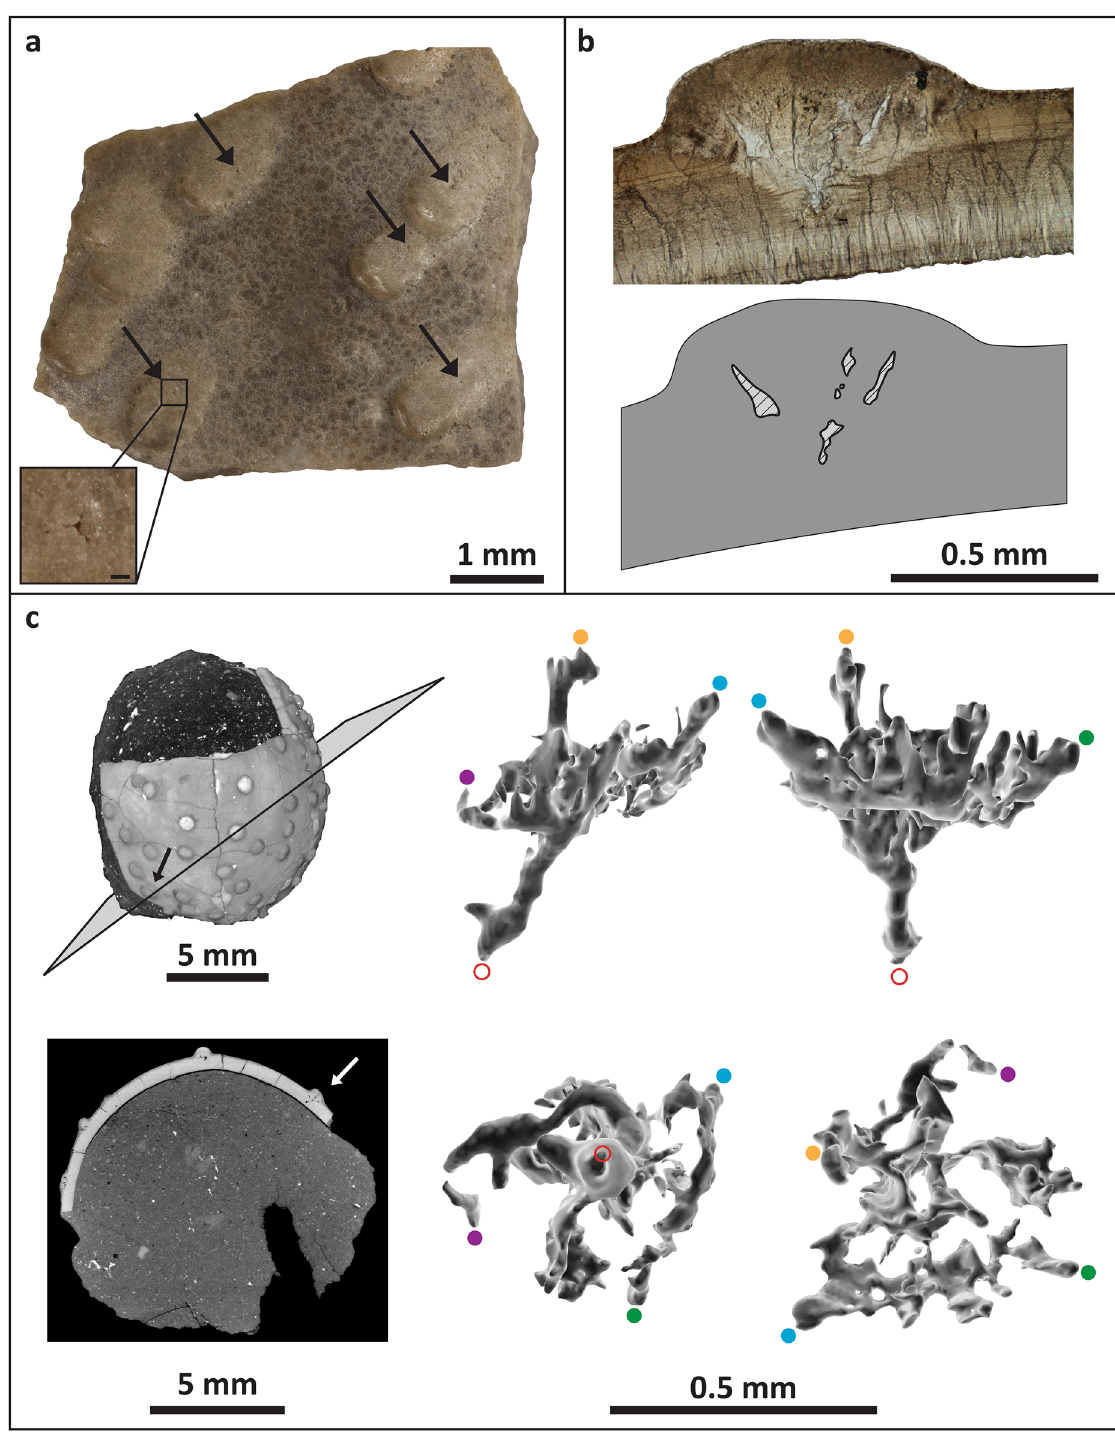
Figure 5. Stillatuberoolithus storrsi oogen. et oosp. nov. pore structure. ( a ) Outer surface of UCM 1073 showing dispersituberculate ornamentation with slightly elongated nodes. Note very small pore openings on the nodes (arrows). Inset shows pore opening with a scale of 0.2 mm; ( b ) Radial thin section of DMNH EPV.65602 (holotype) with diagram highlighting open cavities within the node due to branching pores; ( c ) Rendered CT scans of partial egg (DMNH EPV.128286, paratype). Pore canals are evident within nodes; straight, perpendicular lines in shell between nodes are fractures in the eggshell. A pore canal within a node free of cracks was selected for partitioning (arrow). Four 3D views of the selected pore canal are provided. Upper left and upper right images are lateral views. Lower left image is a view from the base of the pore canal, looking up towards the outer eggshell surface. Lower right image is a view from the top of the pore canal, looking down towards the inner surface of the eggshell. Red open circle indicates where the pore canal meets the inner surface of the eggshell. Orange and blue dots indicate where the pore reaches the outer surface of the node. Purple and green dots provided to assist with orientation. Images in ( c ) generated with Dragonfly software, Version 4.1.0.647 for Windows; software from Object Research Systems (ORS) Inc., Montreal, Canada is available at http:// theob jects. com/ drago